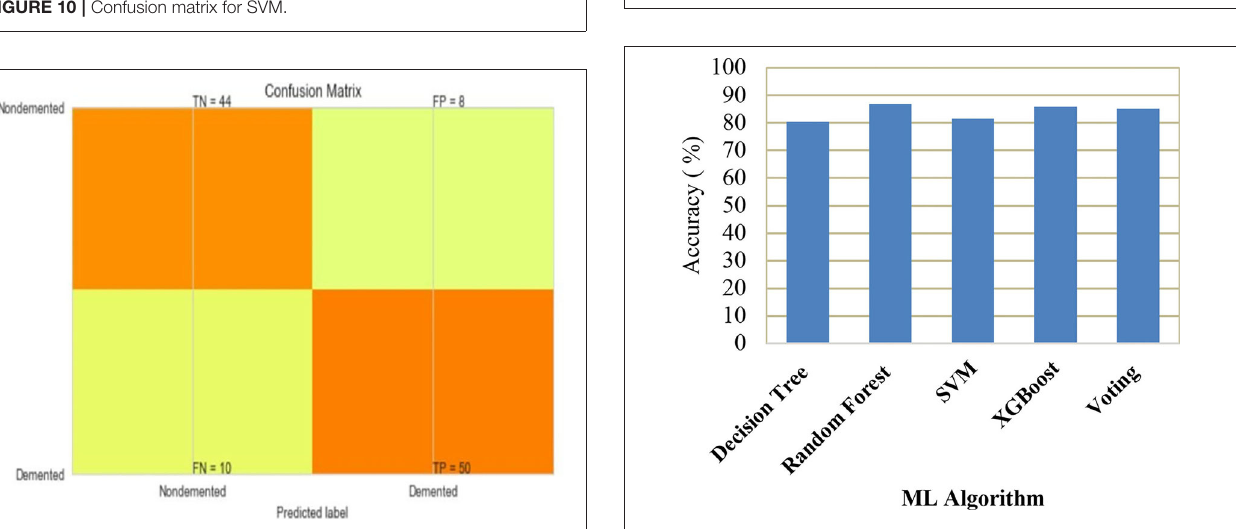
FIGURE 14 | Comparison of